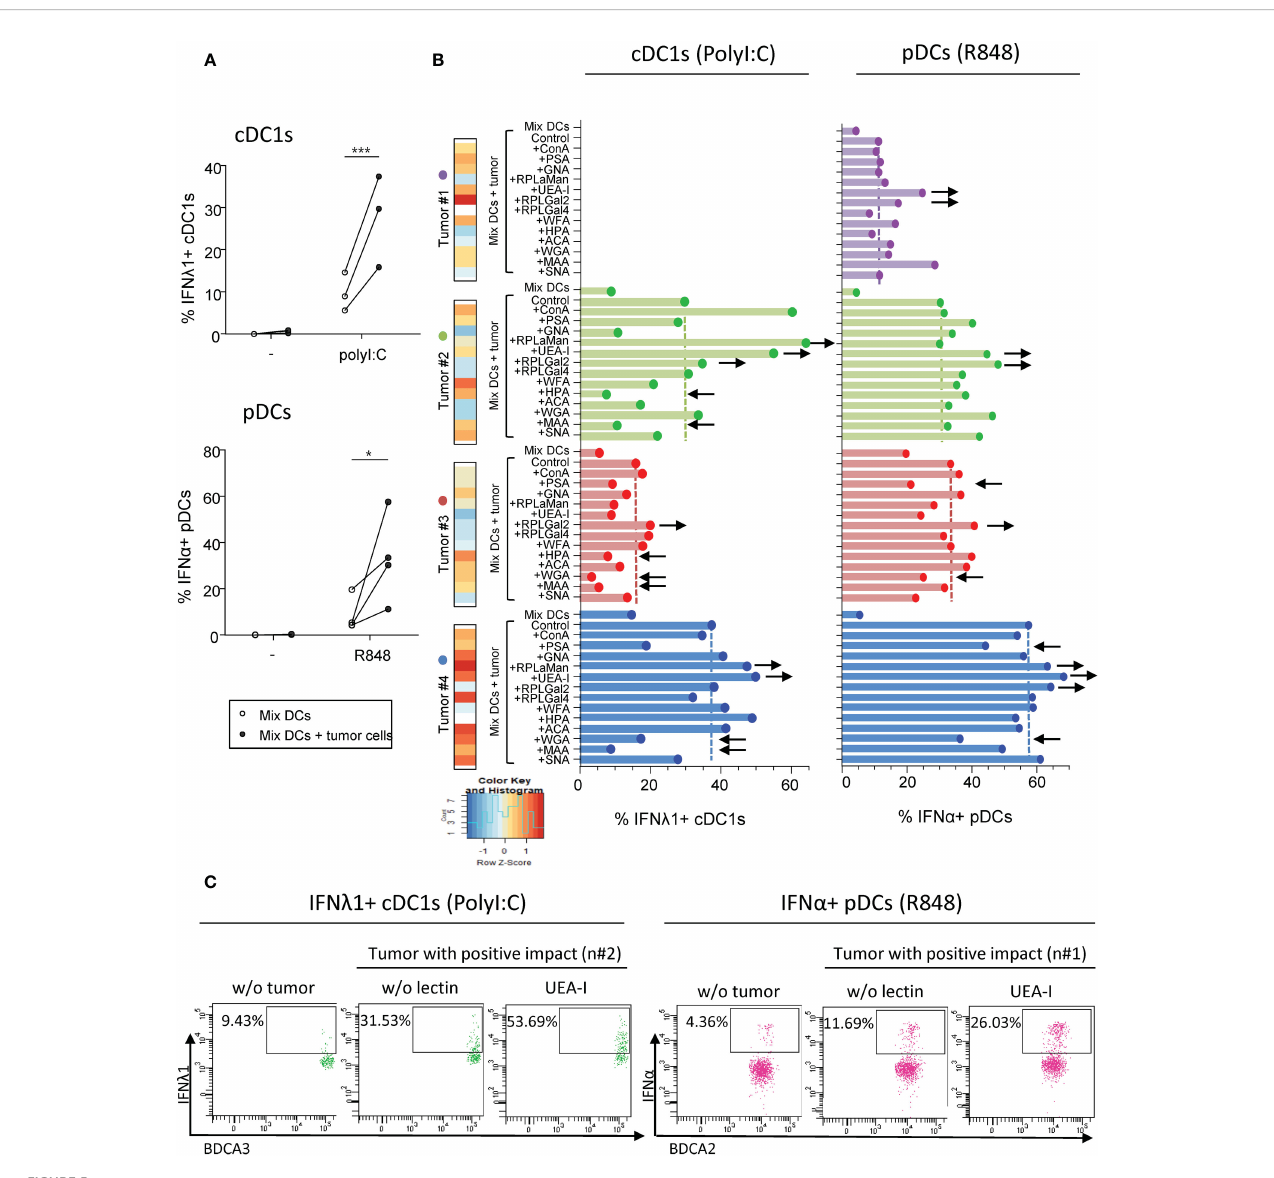
FIGURE 5 Pre-treatment of “ positive ” tumor cells with speci fi c lectins in-vitro further boosts their good impact on cytokine production by cDC1s and pDCs. PanDCs were co-cultured for 20 hours with “ positive ” tumor cell lines previously cultured or not with soluble lectins for 2 hours. Collected panDCs were then stimulated for 5 hours with or without TLR-L (polyI:C, R848) and the production of cytokines was measured using fl ow cytometry. (A) Frequencies of IFN l 1 + cDC1s (higher panel) or IFN a + pDCs (lower panel) upon TLR triggering after co-culture with ( fi lled circles) or without (open circles) tumor cell lines that positively impacted cDC1s or pDCs ’ functionality (called “ positive ” tumors) and that were previously untreated with soluble lectins (n = 3 to 4 different panDC/tumor combos per group). Results are expressed as percentages of cytokine-expressing cells within each group. Only signi fi cant statistics are shown on graphs. P -values were calculated using matched two-way repeated measures ANOVA with Bonferroni ’ s multiple comparisons test. *P-value ≤ 0.05, ***P-value ≤ 0.001. (B) Proportions of IFN l 1 + cDC1s (left panels) and IFN a + pDCs (right panels) upon PolyI:C or R848 stimulation respectively after 20h of culture or not with “ positive ” tumors previously treated or not with soluble lectins (n = 3 or 4 tumors). Lectin binding by each tumor cell line (#1 to 4) was illustrated on the left part and color scaling was done per lectin. Black arrows indicate recurrent down- ( ) or up ( ! ) modulations of cytokine secretion compared to “ MixDCs+tumor ” condition. (C) Representative dot plots highlighting the boost in cytokine production (upon TLR stimulation) by cDC1s (left panels) and pDCs (right panels) after co-culture with “ positive ” tumor cell lines (#2 and #1 respectively) pre-treated with the lectin